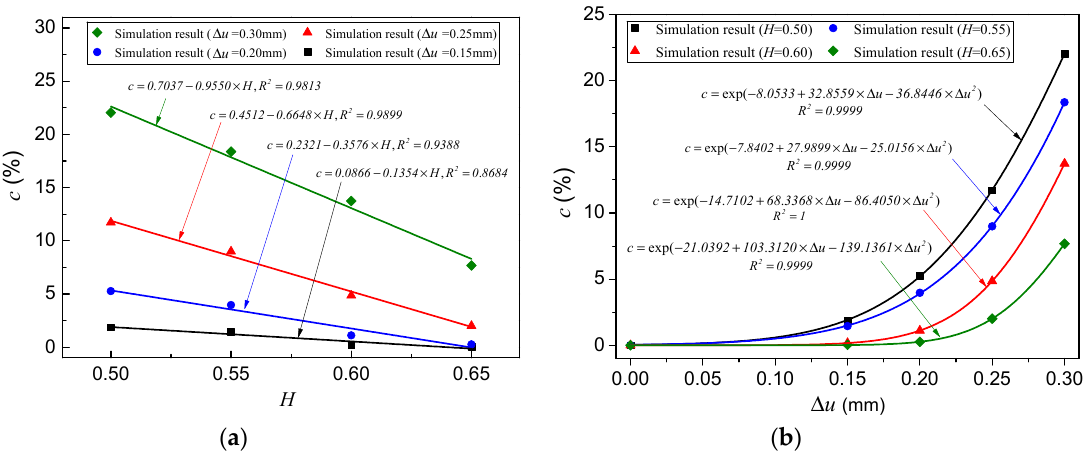
Figure 5. Relationships between the contact area ratio ( c )and H or Δ u for different fractures: ( a ) c versus H ; ( b ) c versus Δ u .